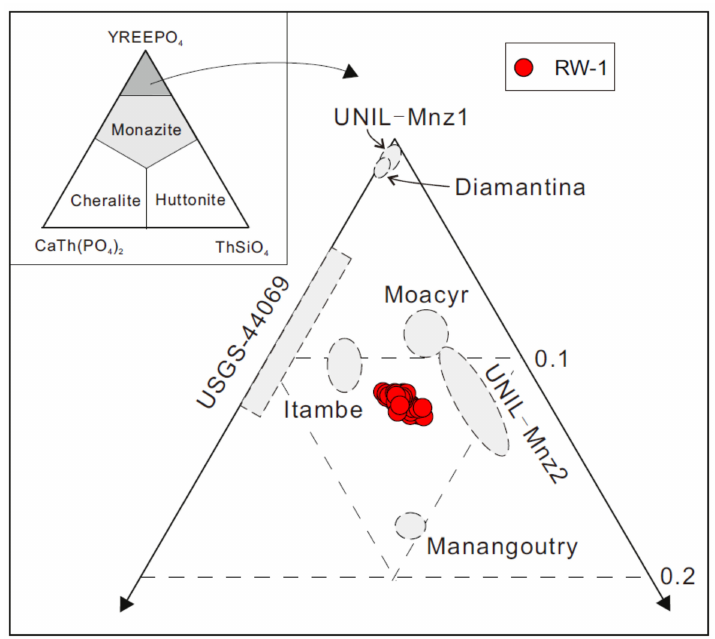
Figure 2. Ternary diagram of monazite end-members: cheralite, huttonite, and monazite. End-members are calculated according to Pyle et al. [8]. The Diamantina, UNIL-Mnz1, USGS-44069, Itambe, Moacyr, UNIL-Mnz2, and Manangoutry data are from Rubatto et al. [14], Didier et al. [15], and Gonçalves et al.